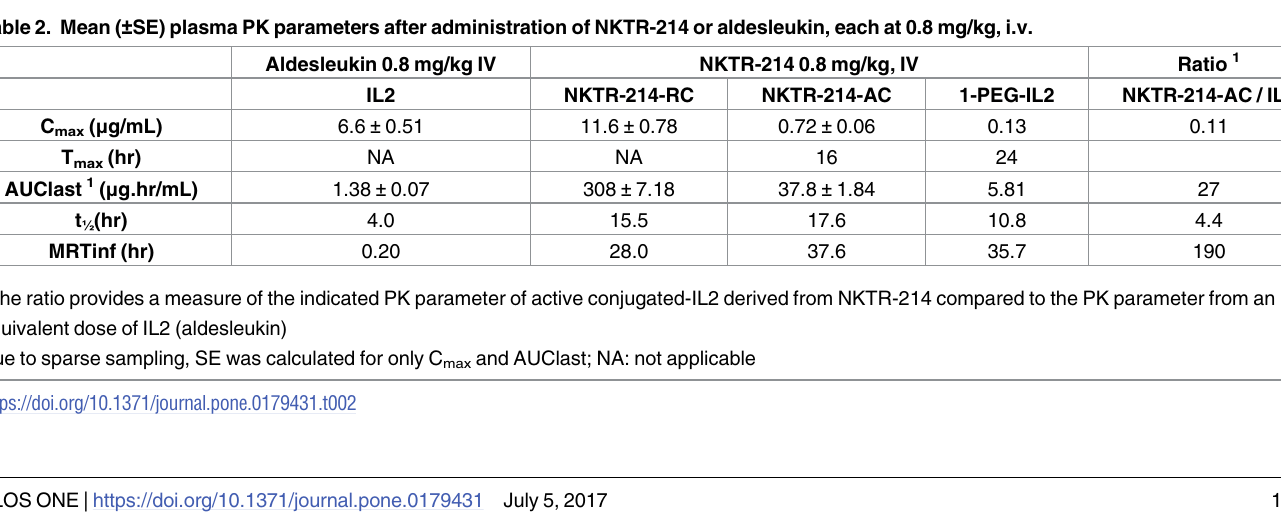
released from NKTR-214.